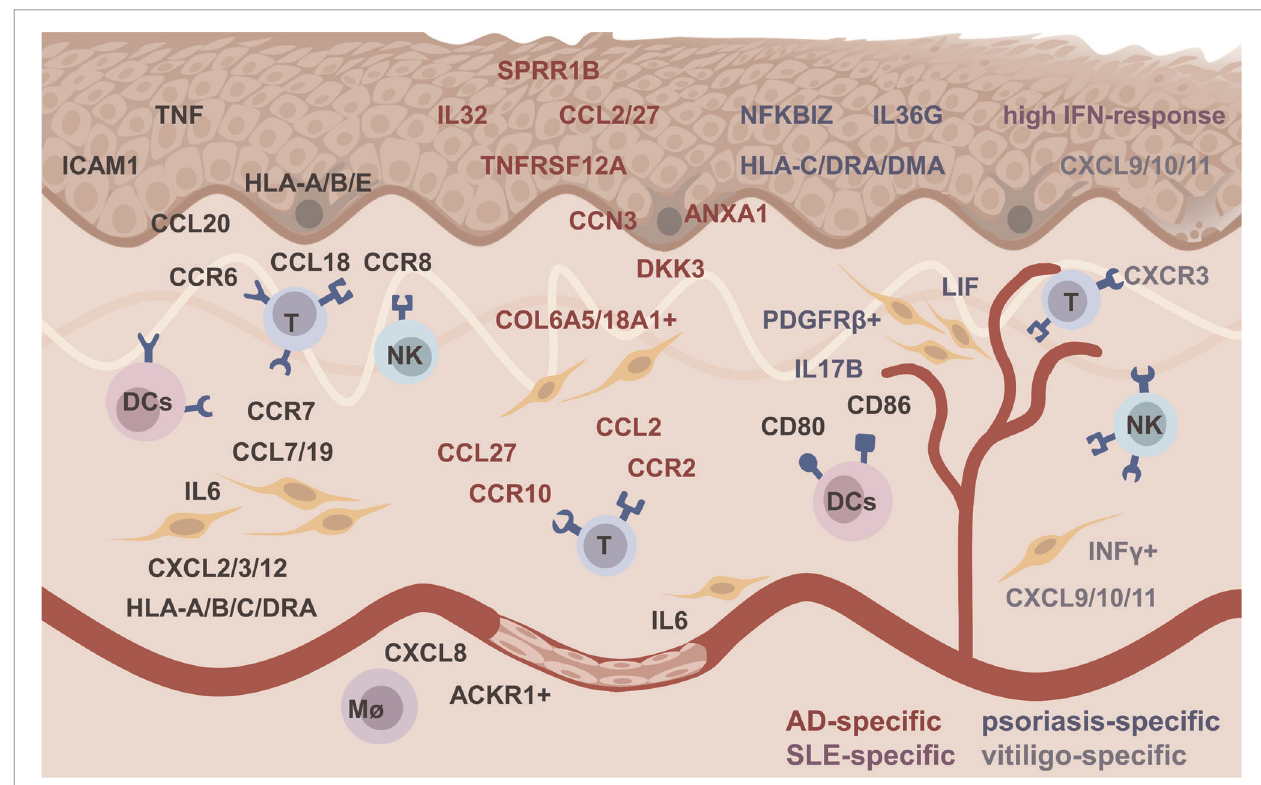
FIGURE 1 | The feedforward role of skin stromal cell in in fl amed skin. Black, red, blue, purple, and gray words represented ubiquitous, atopic dermatitis -speci fi c, psoriasis-speci fi c, systemic lupus erythematosus-speci fi c, and vitiligo-speci fi c altered genes,